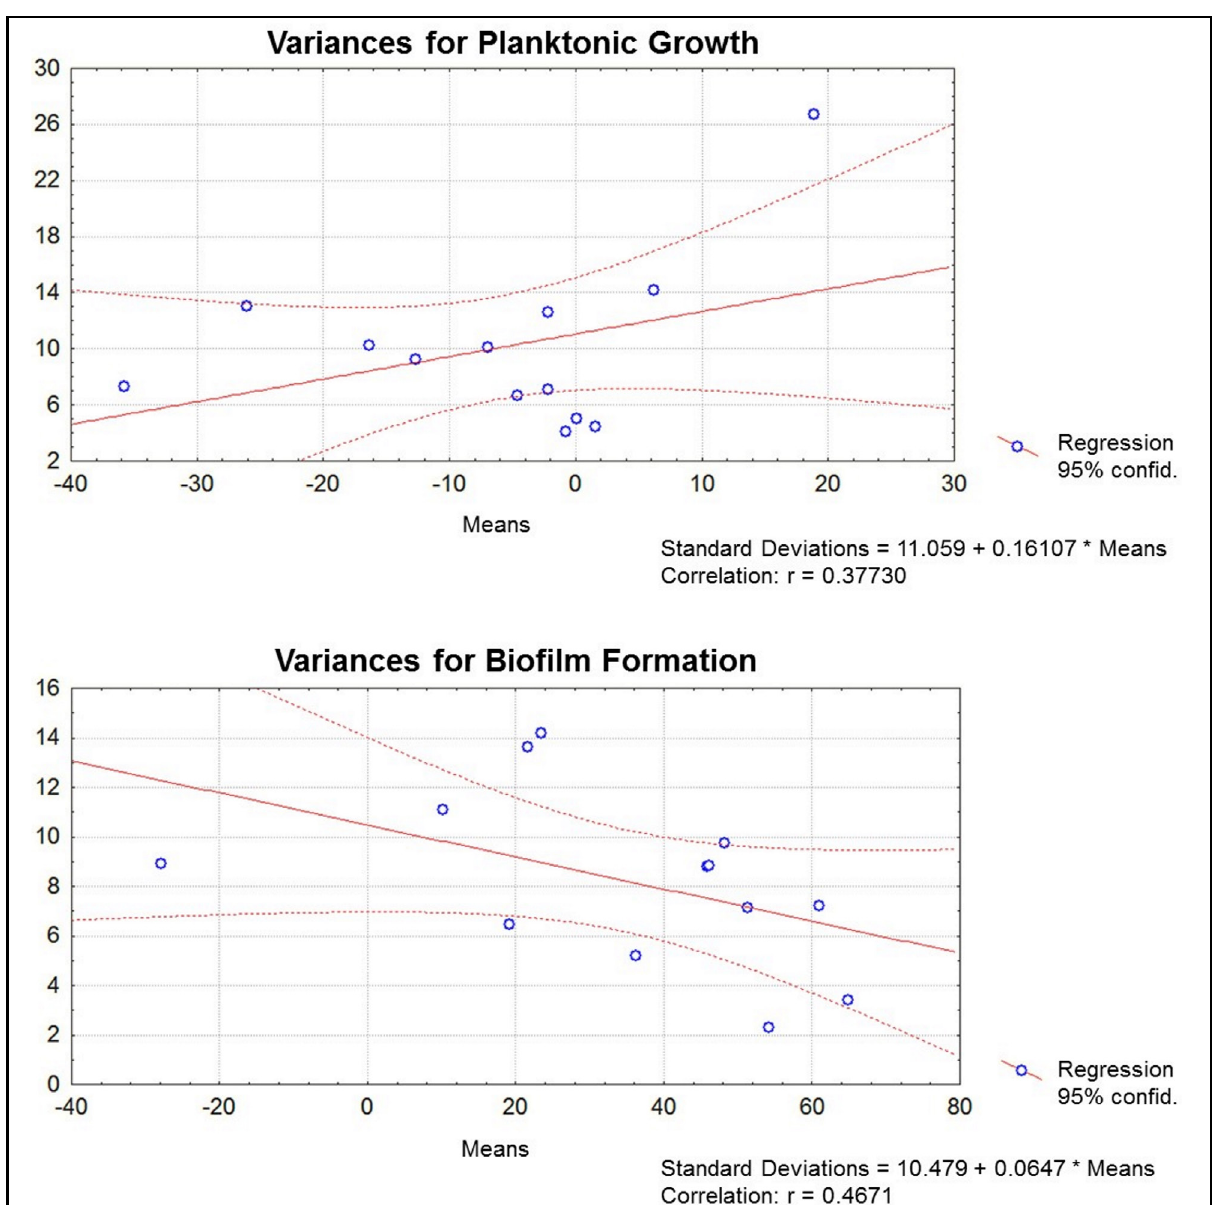
Figure 5- Analysis of variance of the